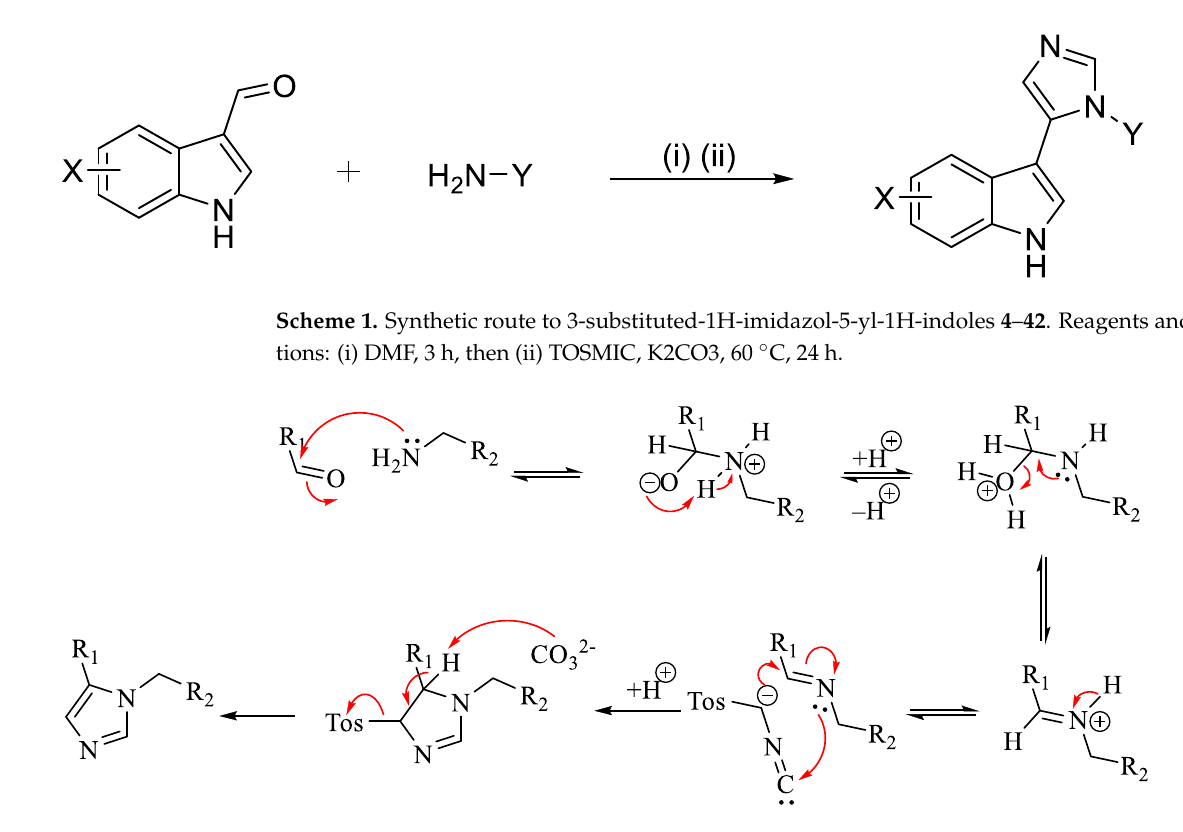
Scheme 2. Proposed reaction mechanism of Van Leusen three-component reaction. Figure 2. Structures of substituted indole-imidazoles 4 – 42 . Figure 2. Structures of substituted indole-imidazoles 4 – 42 .